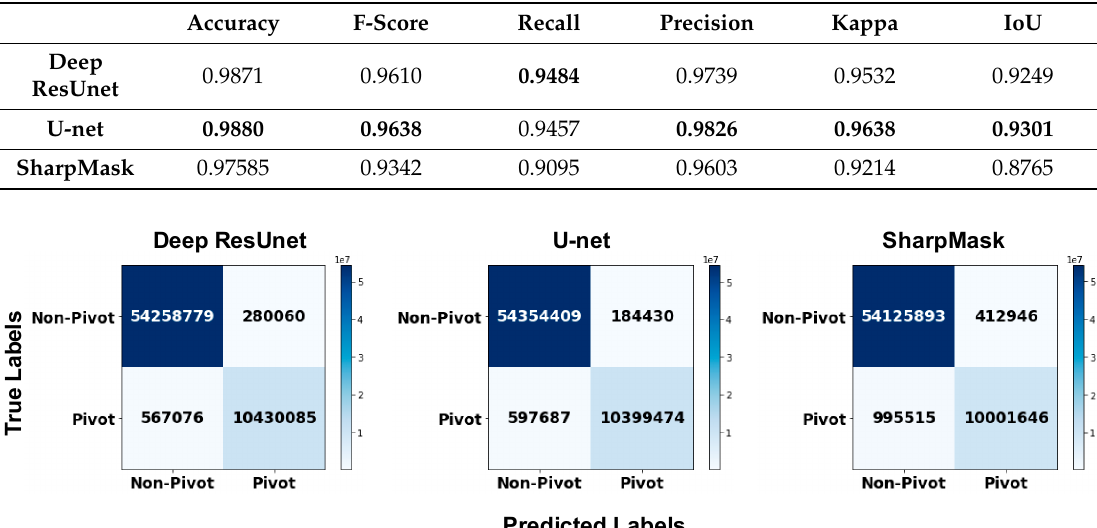
Table 4. Quantitative comparison of accuracy metrics obtained from the segmentation results using Deep ResUnet, U-Net, and SharpMask, where the highest values for each metric are in bold.